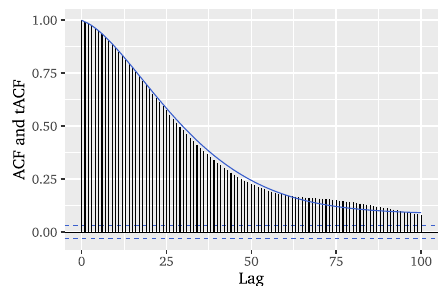
Figure 8. Autocorrelation function of the significant wave height data, compared to the theoretical autocorrelation function of the estimated ARFIMA ( 4,0.1398,4 )